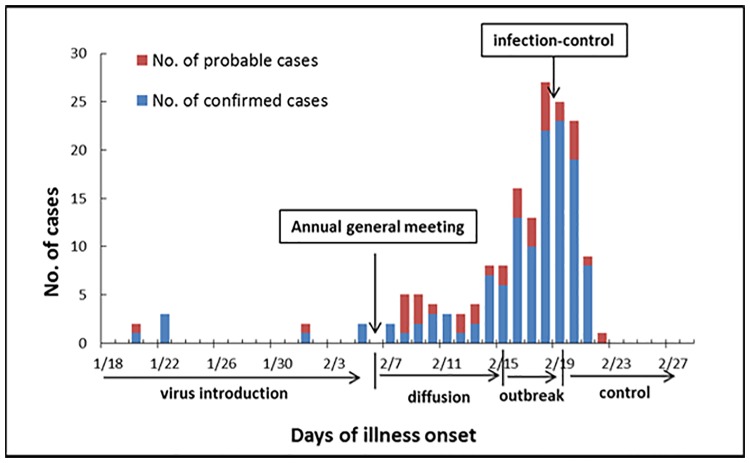
Number of ARD patients admitted to hospital and confirmed cases of HAdV-7 infection in this outbreak.